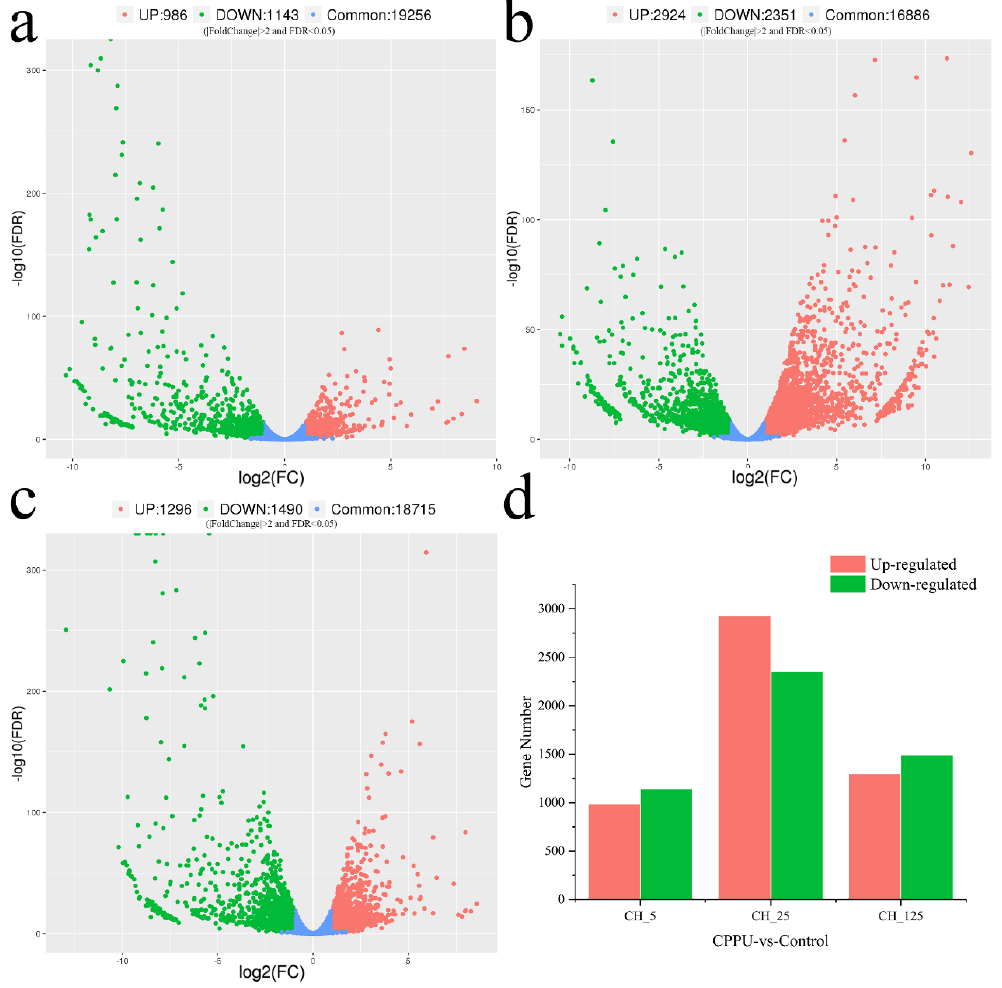
Figure 5. Differentially expressed genes (DEGs) of male catkin treated with three different concen- trations of N-(2-chloro-4-pyridyl)-N’-phenylurea (CPPU) (5 mg·L −1 , 25 mg·L −1 , and 125 mg·L −1 ). ( a – c ) Differential gene expression maps drawn using the fragments per kilobase of exon per million reads mapped (FPKM) method. The red and green dots represent DEGs with |Fold change| > 2 and FDR < 0.05. ( d ) The number of DEGs. The red and green columns indicate up- and down-regulated DEGs, respectively.